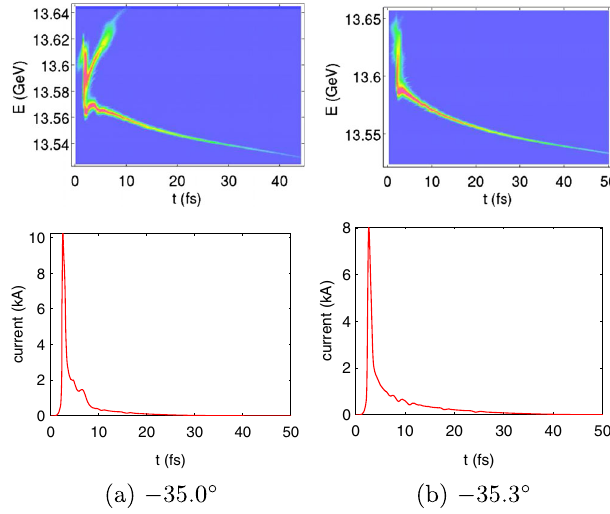
FIG. 5. I MPACT - Z tracking results of electron bunch distribution in the longitudinal phase space (upper) and its current profile (lower) at the LCLS undulator entrance in the case with the L2 rf phase of − 35 . 0 ° (a) and − 35 . 3 ° (b). The L1S rf phase is − 27 °. L1X is with the rf phase of − 180 ° and amplitude of 15